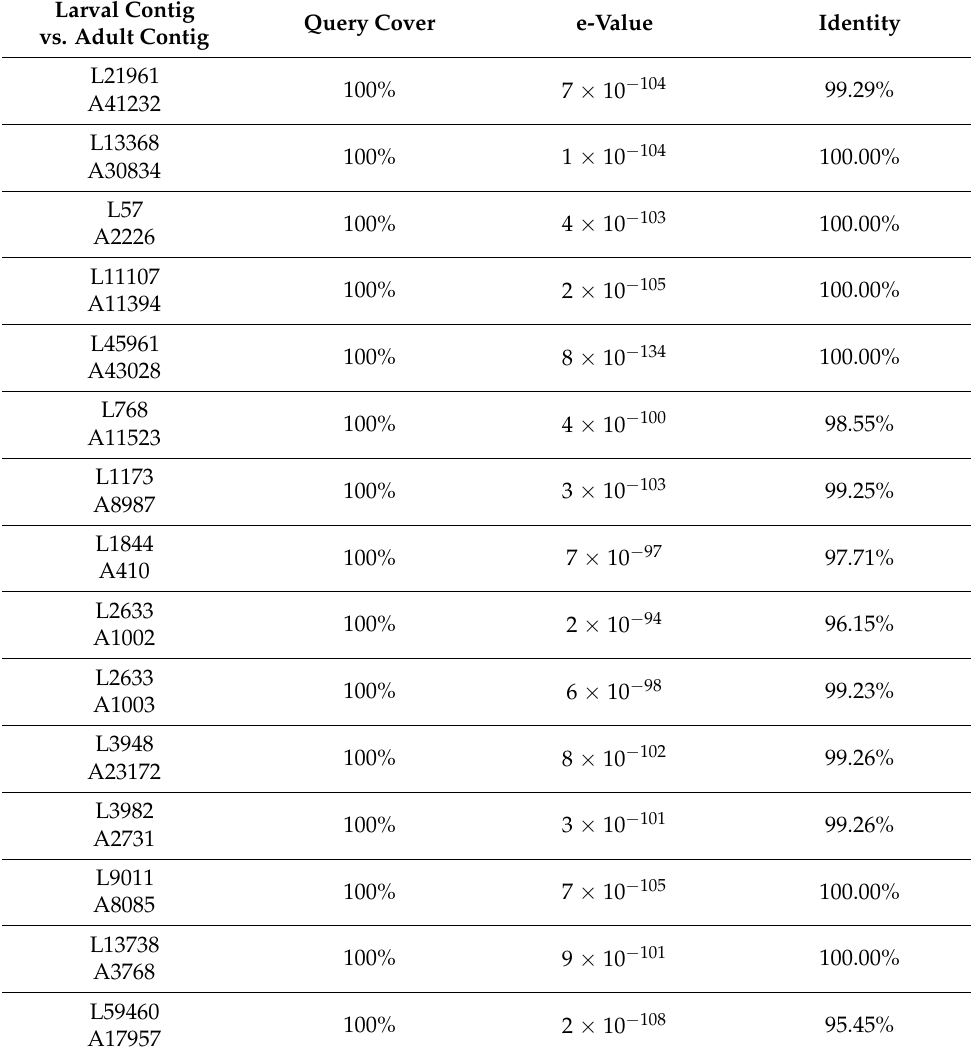
Table 1. Comparison between larval and adult OBPs. Complete OBP sequences from larvae (L) and adult (A) transcriptomes were compared using the Basic Local Alignment Search Tool Protein (BLASTp). Query cover, e-value and identity parameters were reported. The table shows the alignments with a query cover of 100% and an identity greater than or equal to 95%. Larval Contig Query Cover e-Value Identity vs. Adult Contig L21961